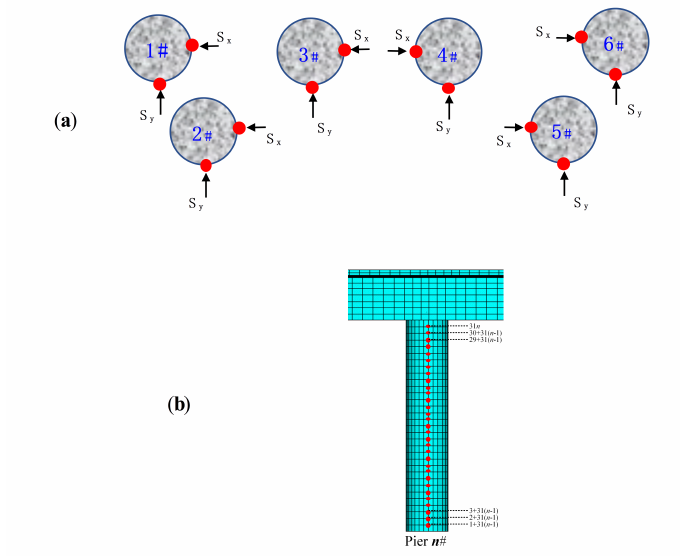
Figure 5. Sensor arrangement on CCGB piers: ( a ) pier number and sensor position; ( b ) vertical distribution of